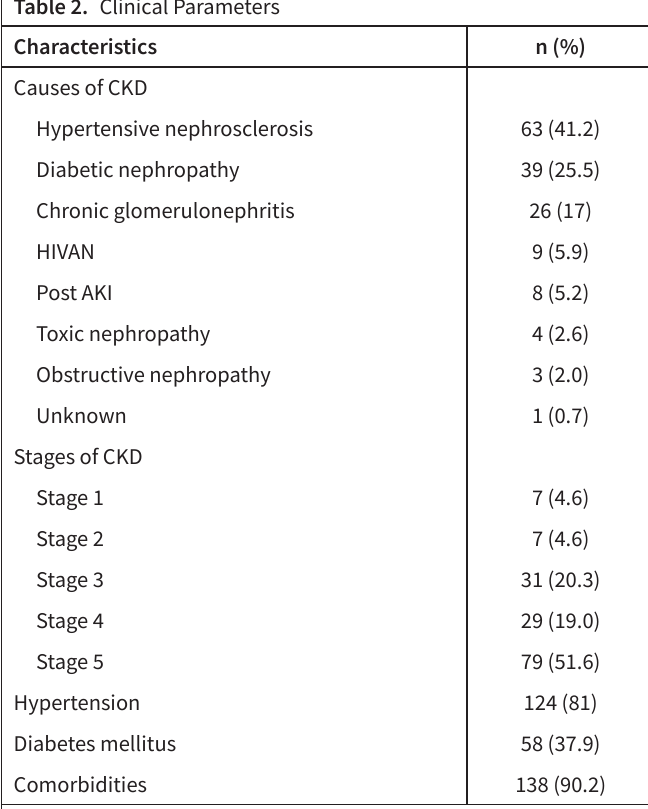
Table 2. Clinical Parameters